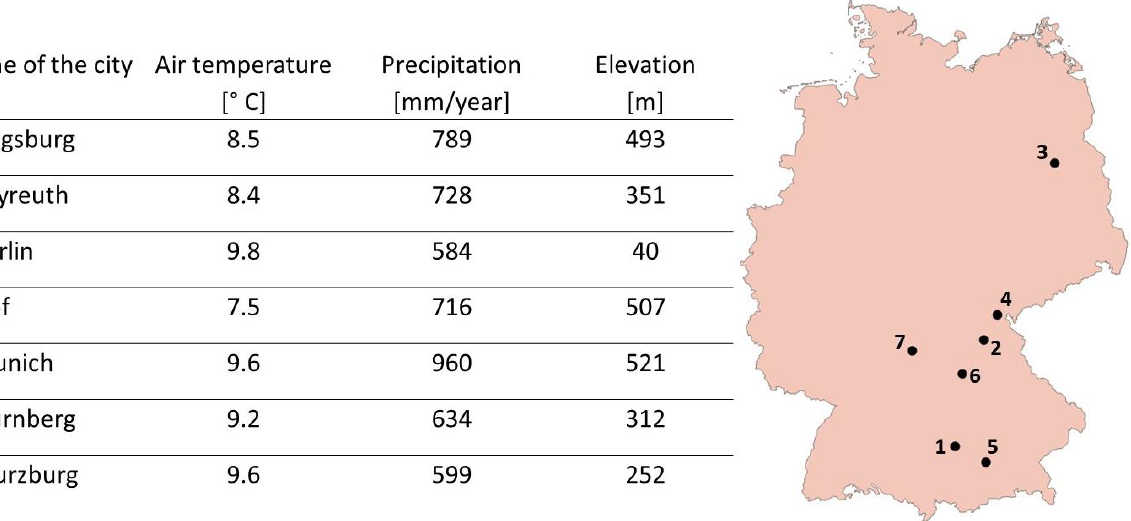
Figure 1. Positions of the eight cities in Germany and averages of annual air temperature and sum of precipitation for the period 1965 – 2015 (data source: DWD Climate Data Center [30]. Cartography realized with QGIS 3.10 Open Street Map and shapefile of Germany available online on DIVA-GIS [31]).